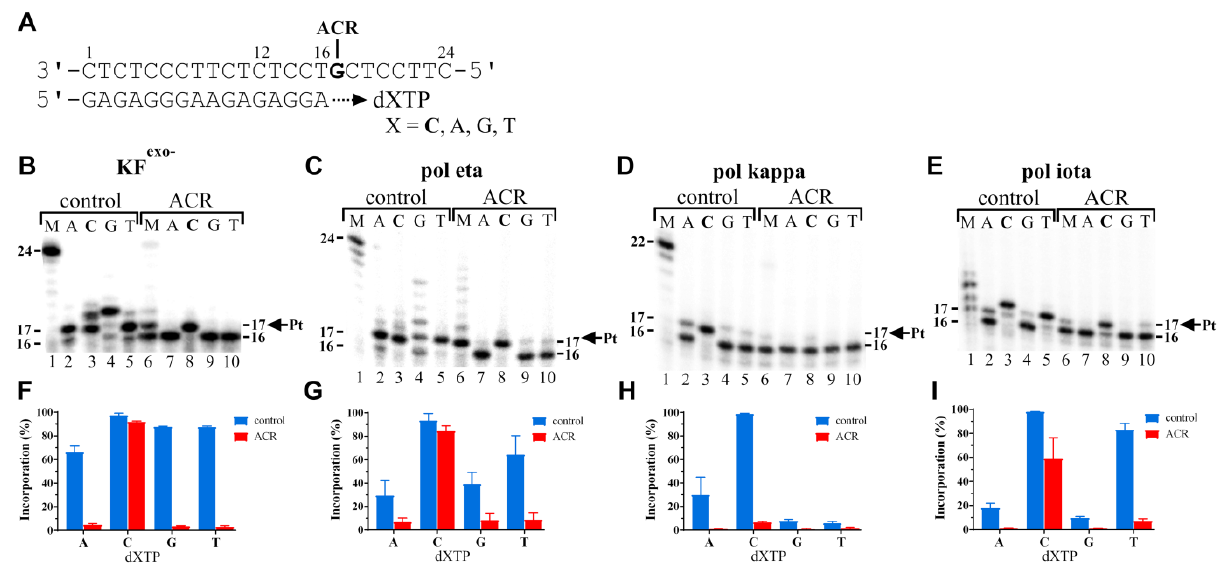
Figure 4. The nucleotide fidelity of the exonuclease-deficient Klenow fragment of DNA polymerase I (KF exo– ), human DNA polymerase eta (pol η ), human DNA polymerase kappa (pol κ ), and human DNA polymerase iota (pol ι ) on the 16-mer/24-mer primer/templates containing a single site-specific adduct of ACR in the presence of dNTPs. The sequence of the primer/template duplex and the position of the platinated guanine are shown in panel ( A ). ( B – E ) Representative images of the products of polymerase reactions resolved on 15% PAA gels. The capacity to elongate a 5 (cid:48) - 32 P-labelled 16-mer primer annealed to the unmodified 24-mer templates (control) or to the 24-mer templates containing ACR in the presence of all the four deoxyribonucleotide 5‘-triphosphates (lanes M, 25 µM each for KF exo– ) or complementary dCTP or noncomplementary nucleotides individually (the corresponding nucleotides in these templates are marked by capital letters above the gels) at 25 °C (KF exo– ) or 37 °C for 60 min or 120 min (pol ι ). The pause sites (product lengths) are shown on the right or left side of the gels. The amount of synthesis was defined as the amount of radioactivity corresponding to the products of incorporation, 17–24 nucleotides long and beyond divided by the total radioactivity in the respective lane (panels F – I ) for each sample. The data are the means (±SEM) from three different experiments.